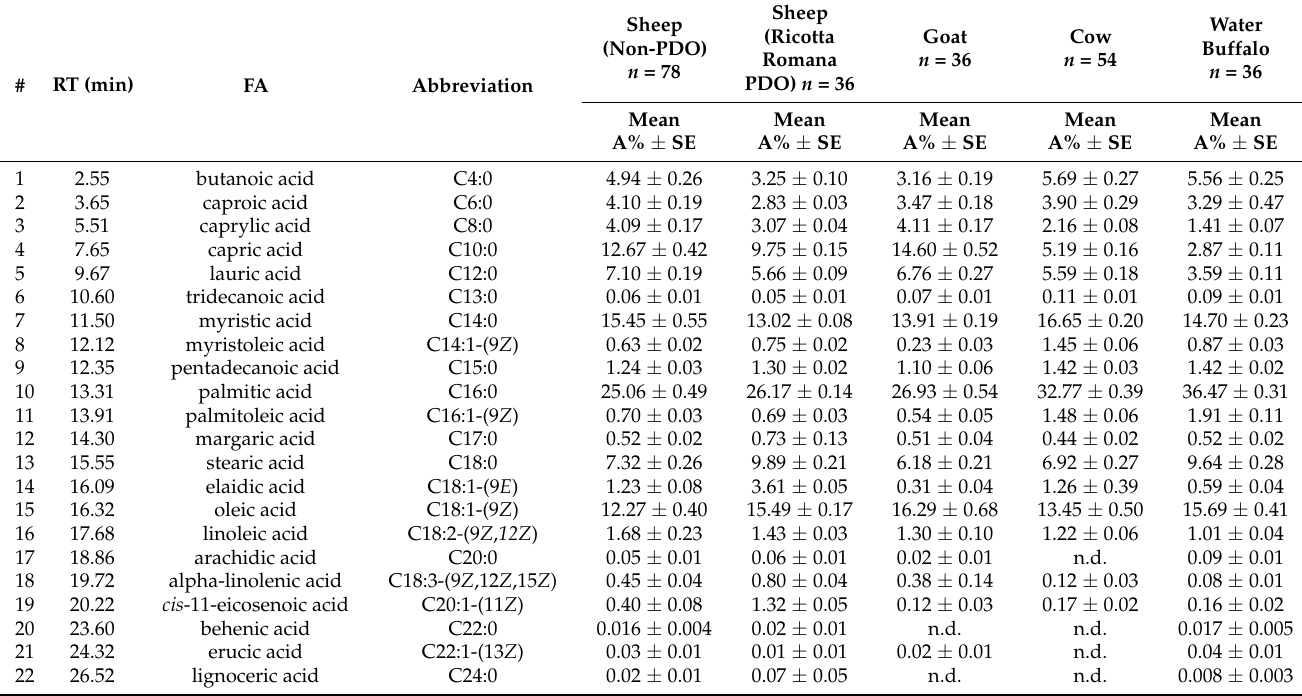
Table 1. FA profiles of ricotta whey cheeses. Peak number (#); RT (min): Observed retention time, FA common name and abbreviation and mean relative (A%) peak area in the GC/FID chromatograms with related standard error